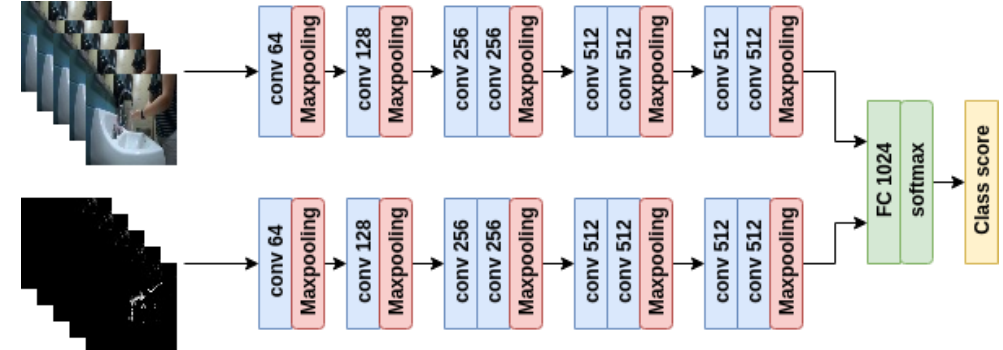
Figure 13. Coarse wall classifier: Model with RGB and motion history image